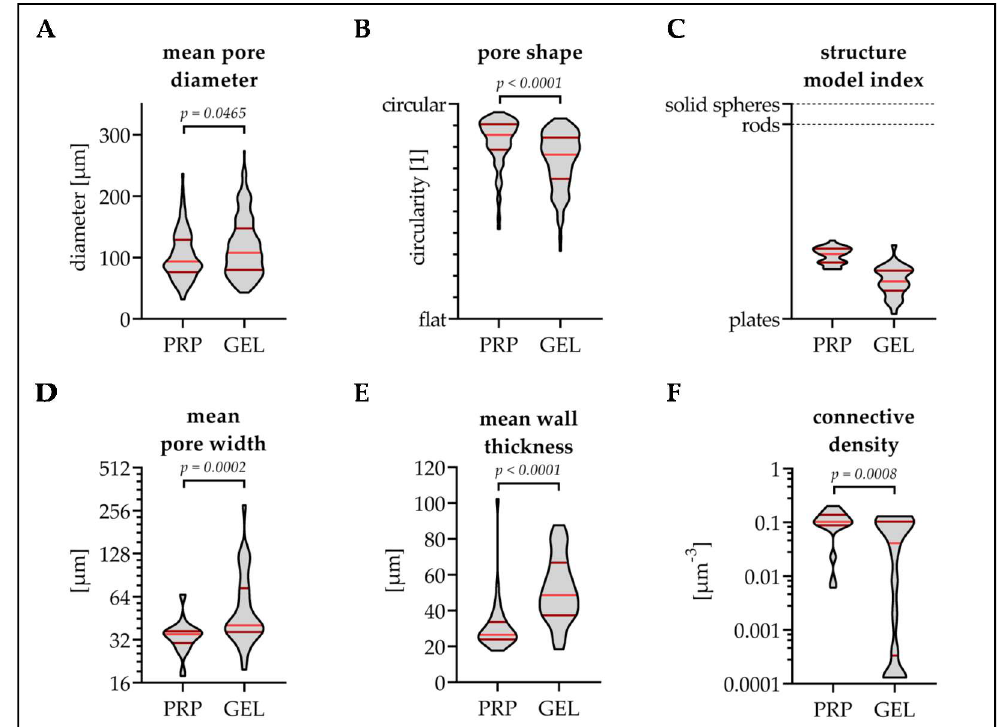
Figure 2. Optical analyses of the pore structure—comparison of the PRP and gelatin (GEL) scaffolds. Scaffold walls were stained with SRB, and the resulting fluorescent images (40× magnification) were analyzed using the ImageJ software. ( A ) Mean pore diameter and ( B ) pore shape were determined manually using the “polygon selection” tool. More detailed analyses were performed using the plugin “BoneJ” which provided information on ( C ) the shape of the walls determined by the “structure model index” after Hildebrand and Rüegsegger; ( D ) the mean pore width determined by the “trabecular separation”; ( E ) the mean wall thickness determined by the “trabecular thickness”; and ( F ) the resulting “connective density”. For each scaffold, 30 images were analyzed. Non-parametric Mann–Whitney U-test was used for data comparison.